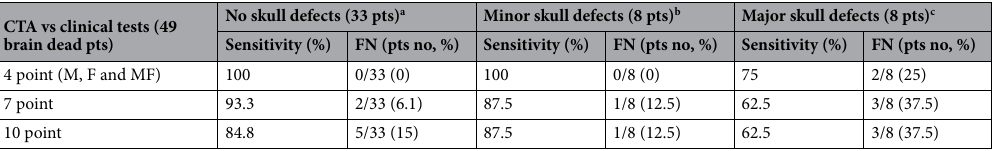
Table 3. Differences between computed tomography angiography (CTA) and clinical tests results according to patients’ skull defects. FN False negative results (patients that were positive for BD according to clinical tests but negative for BD according to CTA tests). a P = 0.008, b P = 0.39, c P = 0.06 (Cochran’s Q